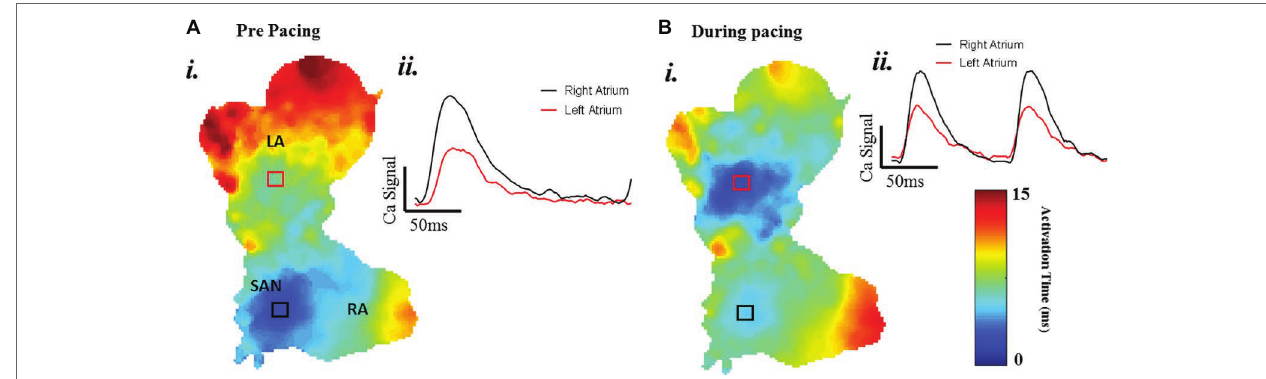
FIGURE 3 | The change of atrial conduction in optogenetic mice during after blue light stimulation. Maps produced by mapping the midpoint time of the CaT rise. (A) Ca 2+ transient activation map during intrinsic pacing, before optical pacing. (B) Ca 2+ transient activation map during optical pacing with blue (470 nm) light